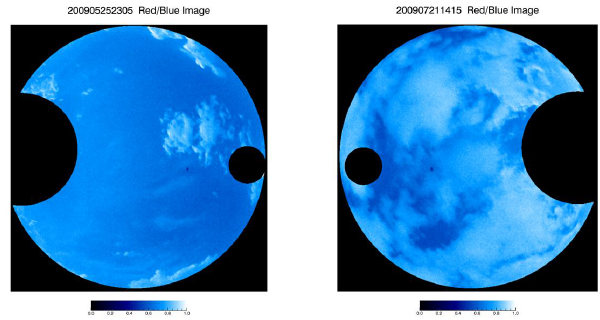
Figure 8. a) Red/Blue ratio image for May 25, 2009. b) Red/Blue ratio image for July 21, 2 Fig. 8. (a) Red/blue ratio image for 25 May 2009. (b) Red/blue ratio image for 21 July